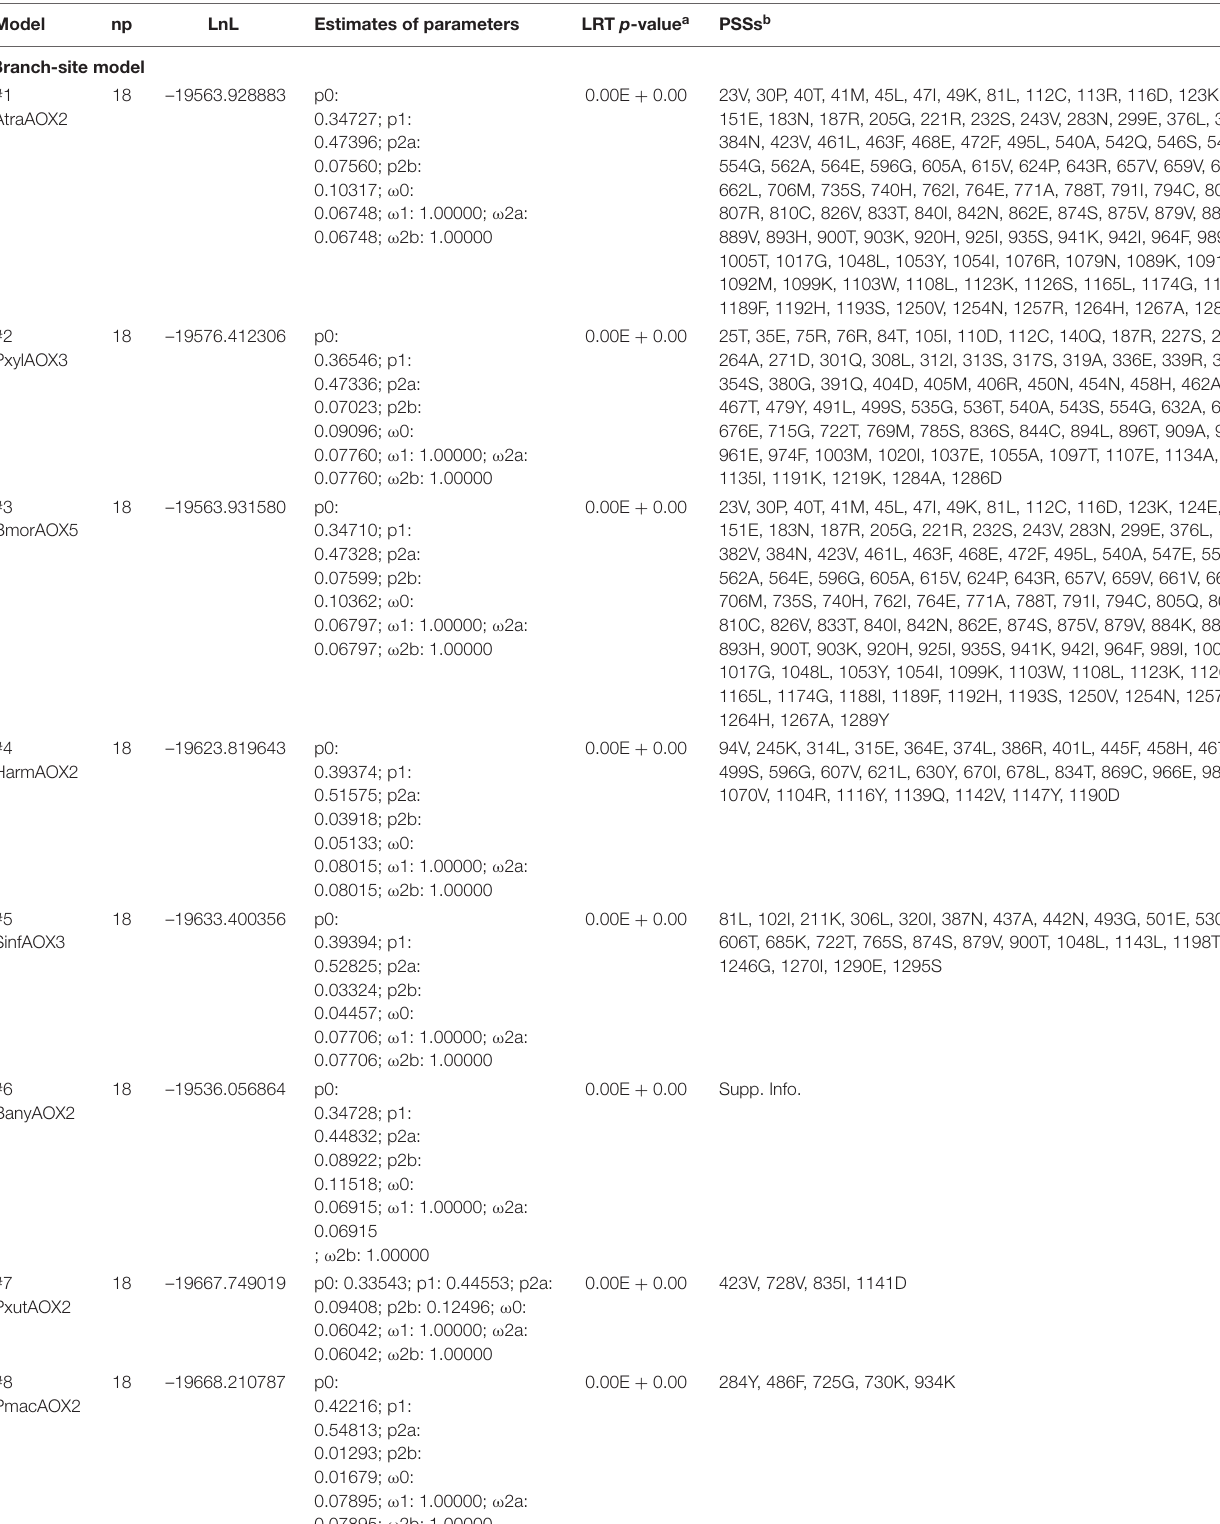
TABLE 3 | Positive selection analysis using branch-site model on 8 lepidopteran AOX